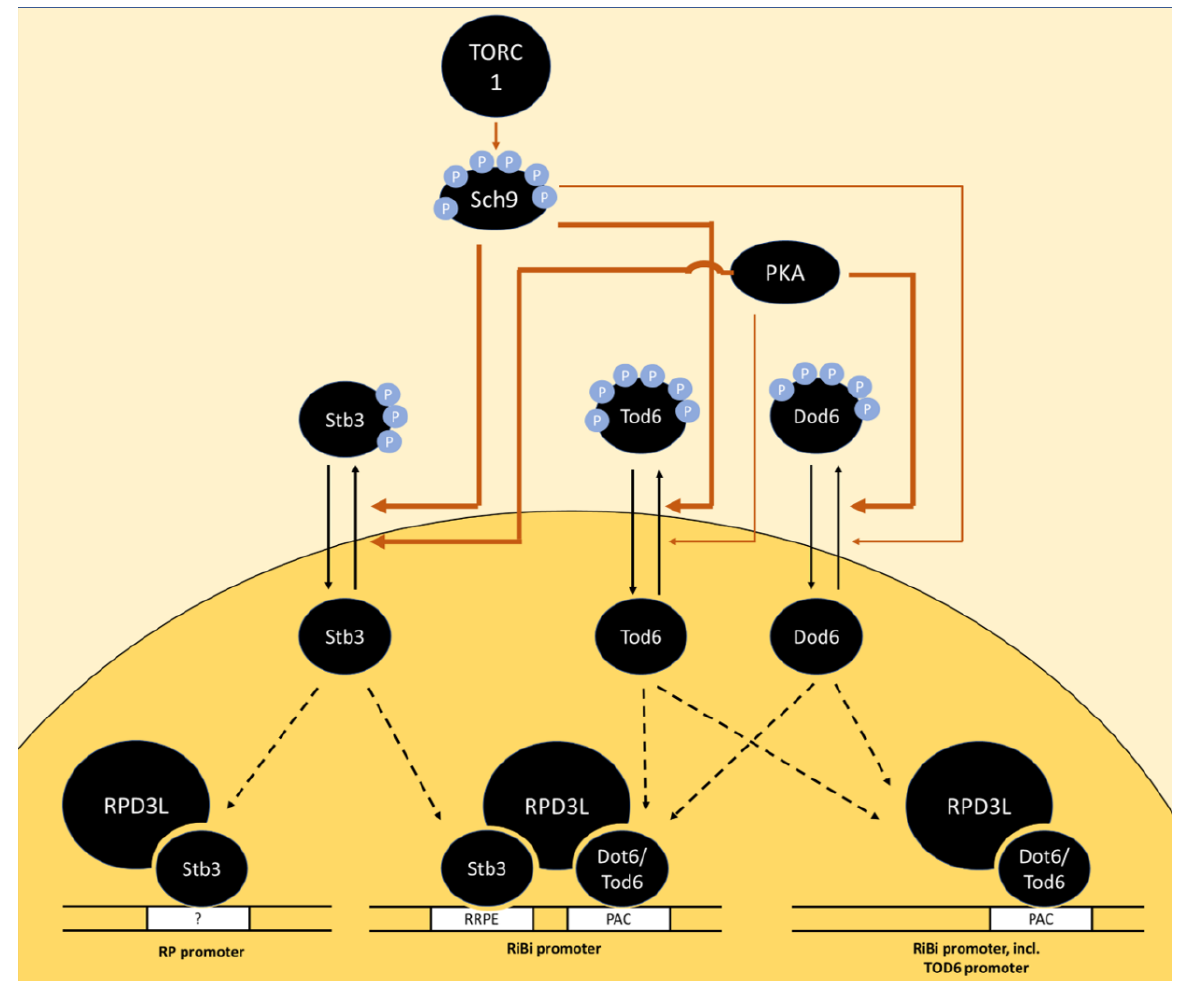
Figure 2. Model of the regulation of RP and RiBi genes via the transcriptional repressors Stb3, Tod6 and Dot6 downstream of TORC1 and PKA. In the absence of phosphorylation by Sch9 and PKA, the transcription factors Stb3, Tod6 and Dot6 bind specific promoter elements upstream of a subset of RP and RiBi genes, triggering their repression via the recruitment of histone deacetylase complex RPD3L. The promoter element bound by Stb3 in RP promoters is marked with a question mark as RP promoters generally do not contain RRPE sequences and the mode of interaction with these promoters is unclear. The thickness of arrows indicates a potentially stronger relative contribution of PKA than Sch9 on Dot6 phosphorylation and vice versa for Tod6 phosphorylation. Potential dephosphorylation of Tod6 by PP2A is omitted as direct evidence is